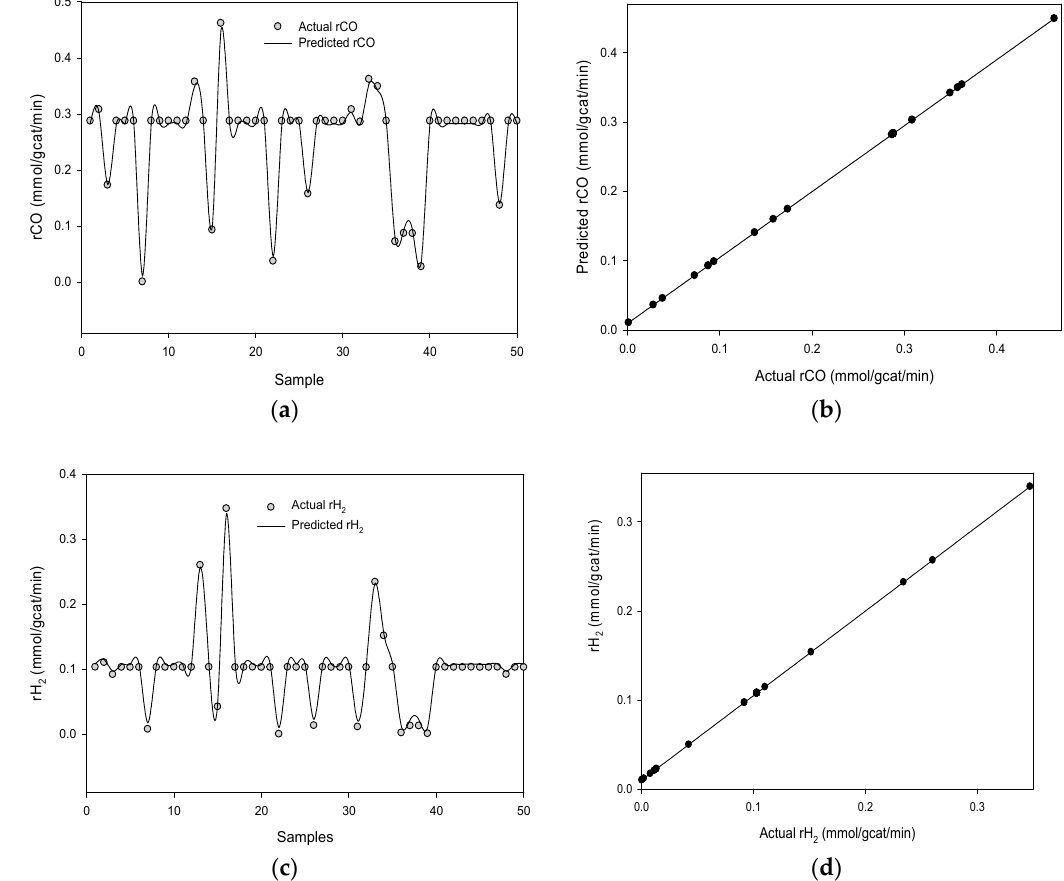
Figure 7. ( a ) Dispersion plot showing the comparison between actual and predicted rCO; ( b ) Parity plots showing the comparison between actual and predicted rCO; ( c ) Dispersion plot showing the comparison between actual and predicted rH 2 ; ( d ) Parity plots the comparison between actual and predicted rH 2 using Bayesian regularization algorithm.